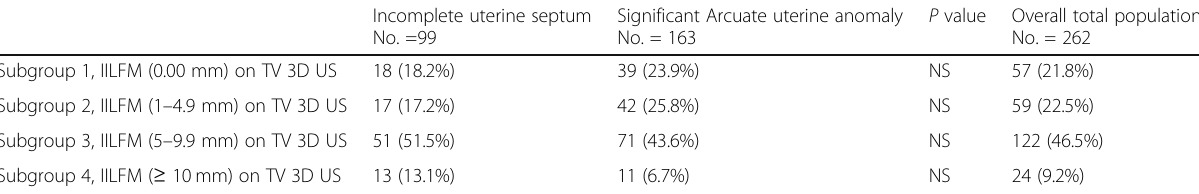
Table 3 Percentage of patients with IUS and AUA and a significant internal indentation (> 15 mm) on hysteroscopy, in 4 subgroups based on the internal indentation length on TV 3D US with or without SIH